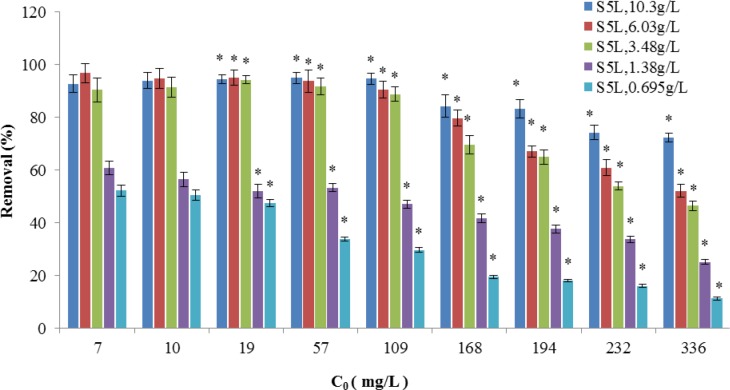
Removal efficiency of the S5L strain under different Cd2+ concentrations (mg/L) (*p<0.05,*based on the value of 7mg/LCd2+).